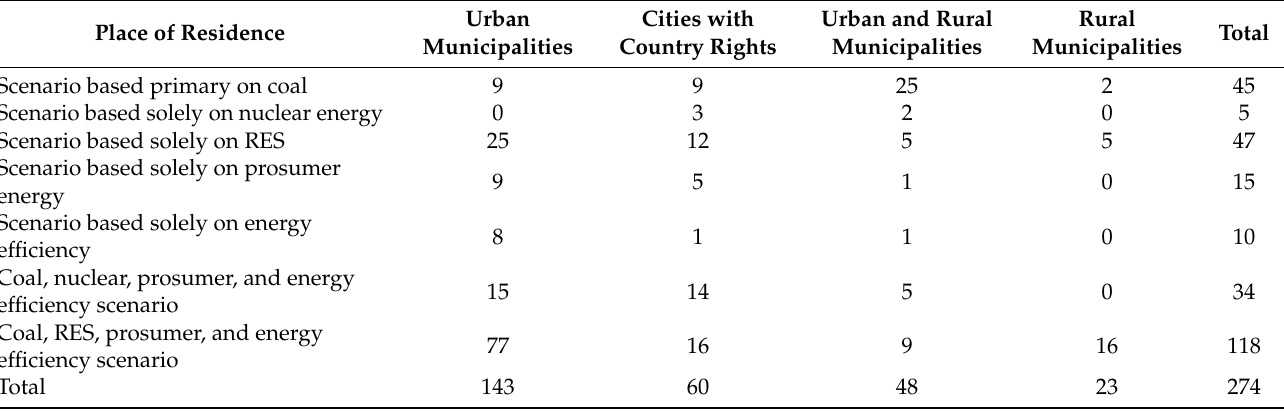
Table 4. Residents’ opinion on the optimal energy mix for